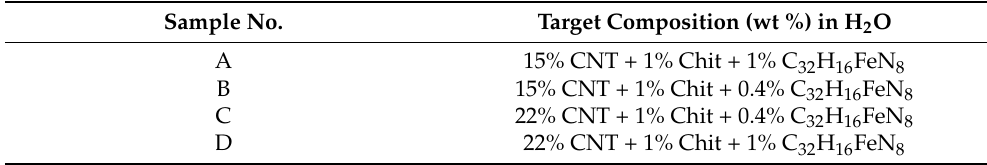
Table 1. Composition of the targets used for the MAPLE experiments. Sample